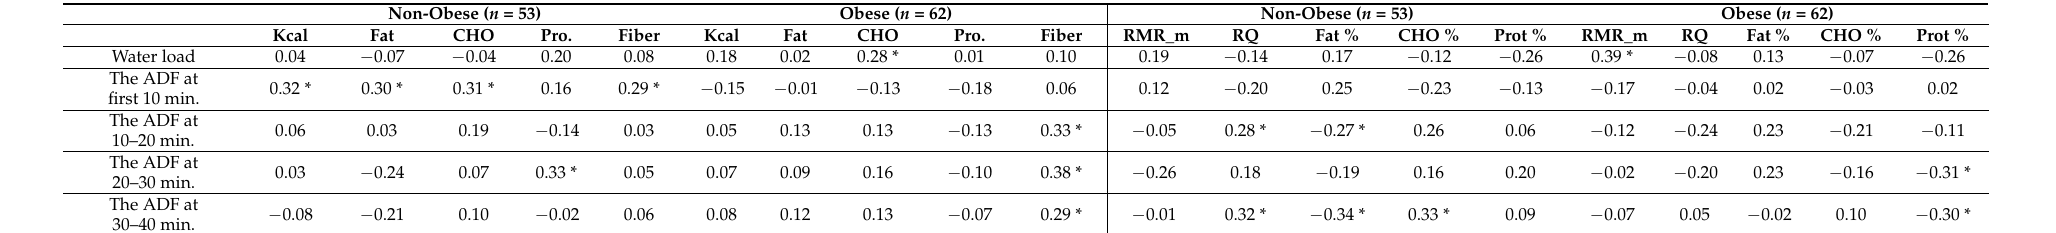
Table 6. Pearson Correlation coefficient between gastric myoelectrical activity and dietary intakes as well as parameters of indirect calorimetry in study participants assigned as two groups (Non-obese and Obese